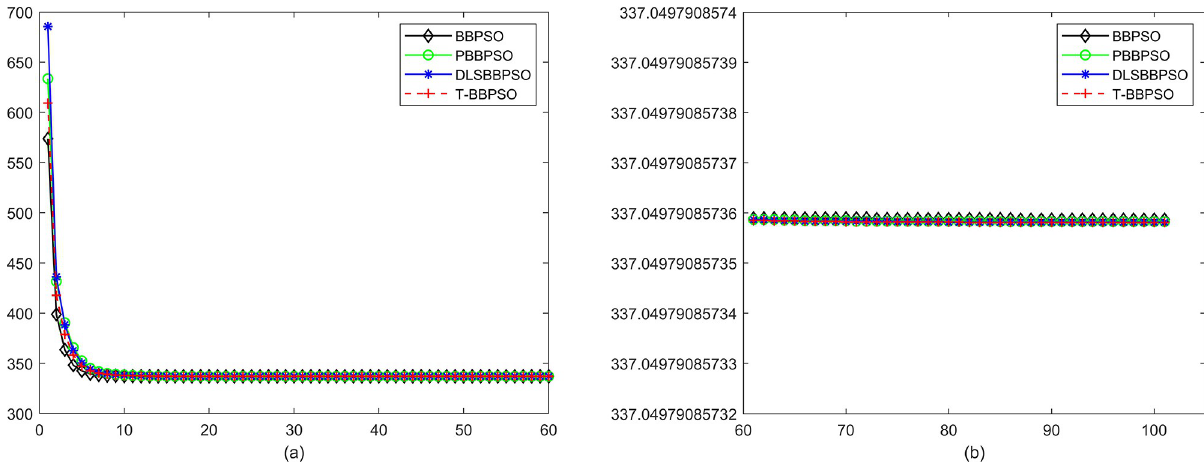
Fig 25. Comparison of convergence speed between BBPSO, PBBPSO, DLS-BBPSO and TBBPSO, f 23 , (a) iteration 0–6000, (b) iteration 6000–10000 the unit is 100 iteration.